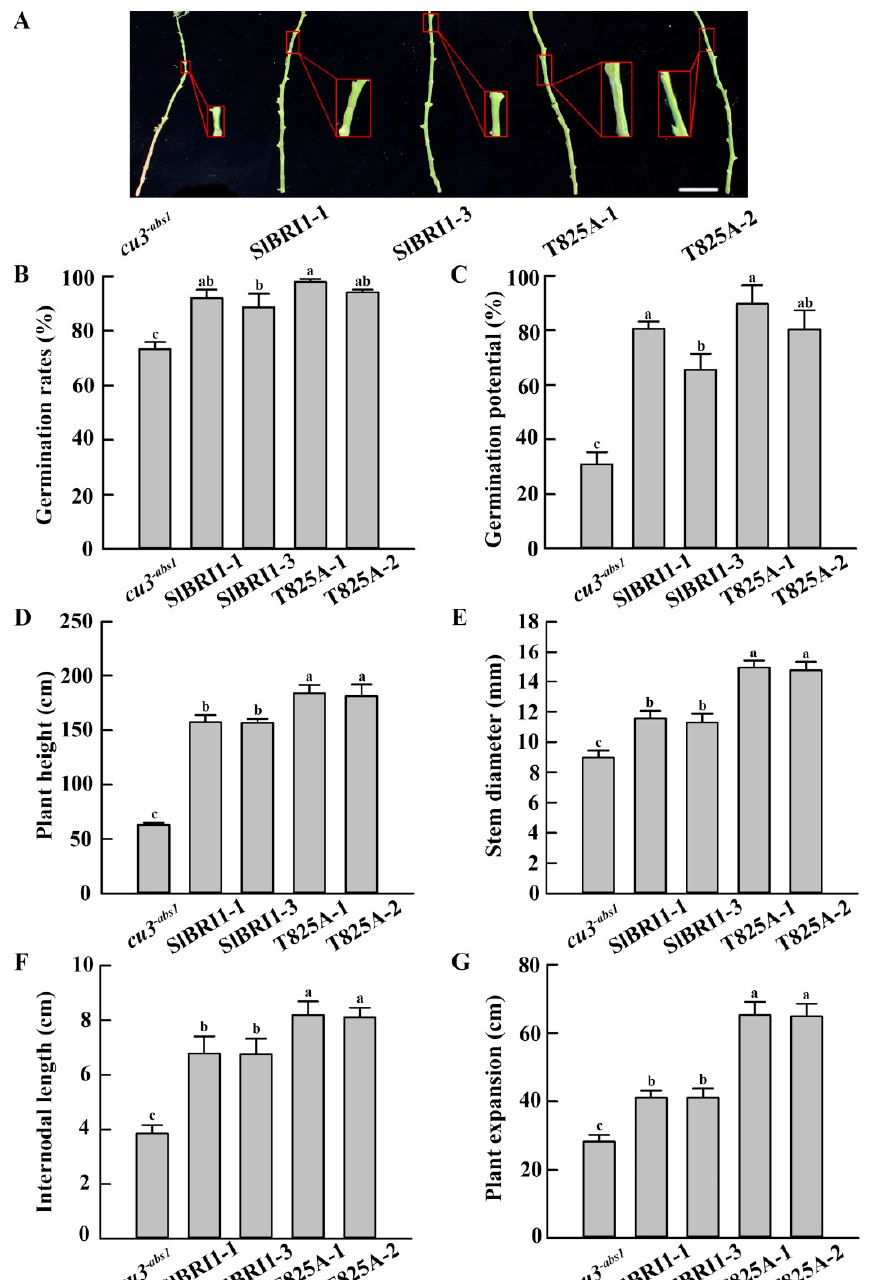
Figure 3. SlBRI1 T825A promotes plant growth. ( A ) Phenotypes of plant stems at the mature stage. The maturation period of the fourth fruit cluster of the P SlBRI1 ::T825A lines was regarded as the mature period. The red rectangular box indicates the eleventh fruit nodes from bottom to top per plant under a 2.5x-magnified visual field. Scale bar represents 14 cm. ( B , C ) Germination rates ( B ) and the germination potential ( C ) of plants on the seventh day and third day after sowing at 28 °C in the dark, respectively. ( D – G ) Plant height ( D ), stem diameter ( E ), internodal length ( F ), and plant expansion ( G ) per plant at the mature stage. The data for ( B , C ) are presented as the mean ± SD ( n = 3), and each replicate had 100 seeds. The data for ( D , E ) are presented as the mean ± SD ( n = 10). The data for ( F , G ) are presented as the mean ± SD ( n = 15). The different letters indicate significant differences (one-way ANOVA, Tukey’s test, p < 0.05).